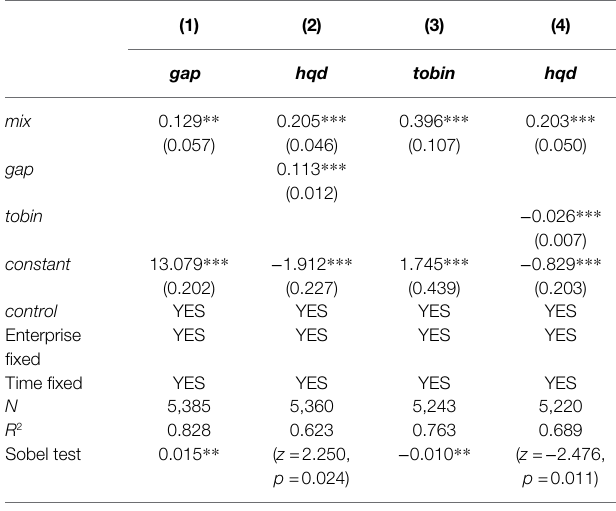
TABLE 11 | The regression result of mediate effect based on internal competition incentive and capital speculation